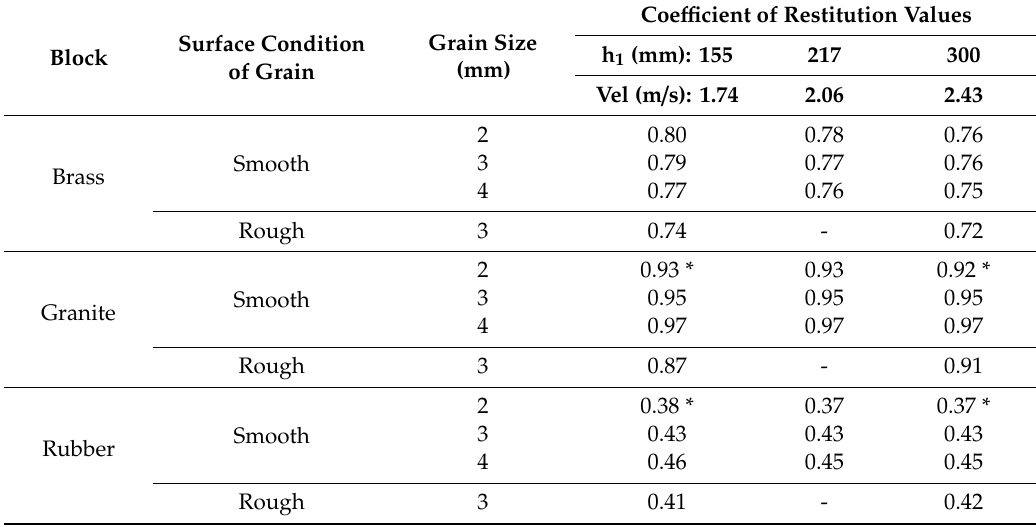
Figure 5. The average values of the coefficient of restitution for 2, 3 and 4 mm sized glass balls impacting on various base blocks.